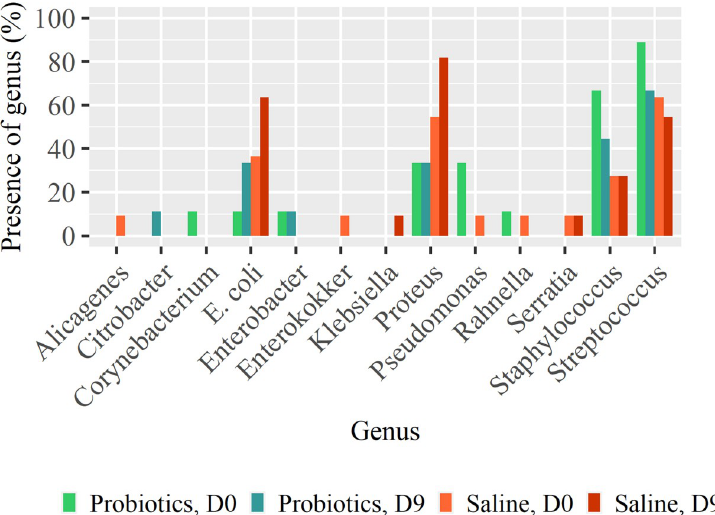
Fig 4. The percentage of probiotic- and saline treated wounds positive on culture of bacteria from various genus at day 0 and day 9.